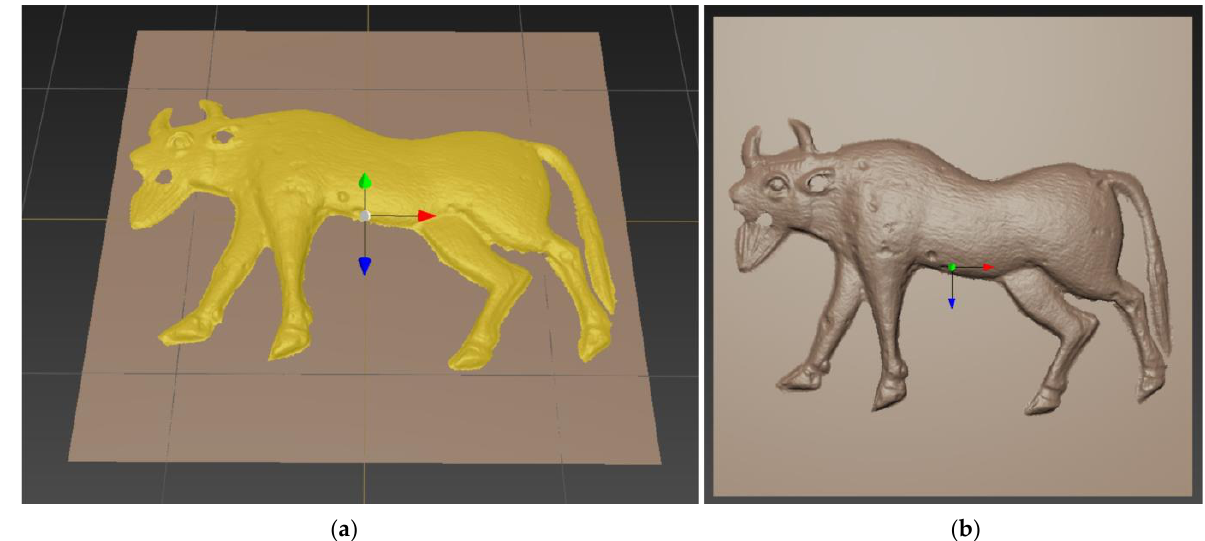
Figure 7. ( a ) Overlapped ornament positioned over the plane prefab in Mudbox; ( b ) Top view of the aurochs’ ornament.